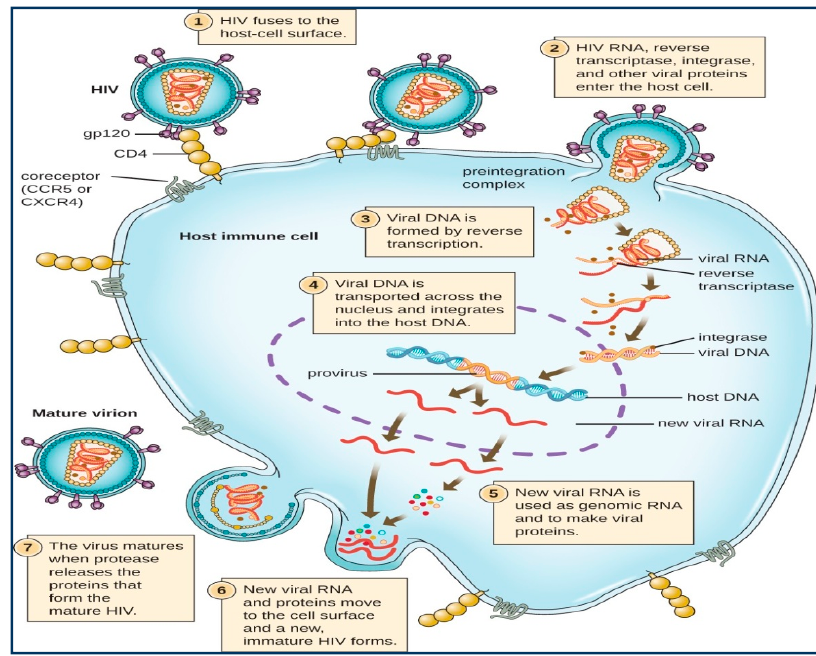
Figure 2. The HIV replication cycle [13]. Image was originally published within Open Access license.